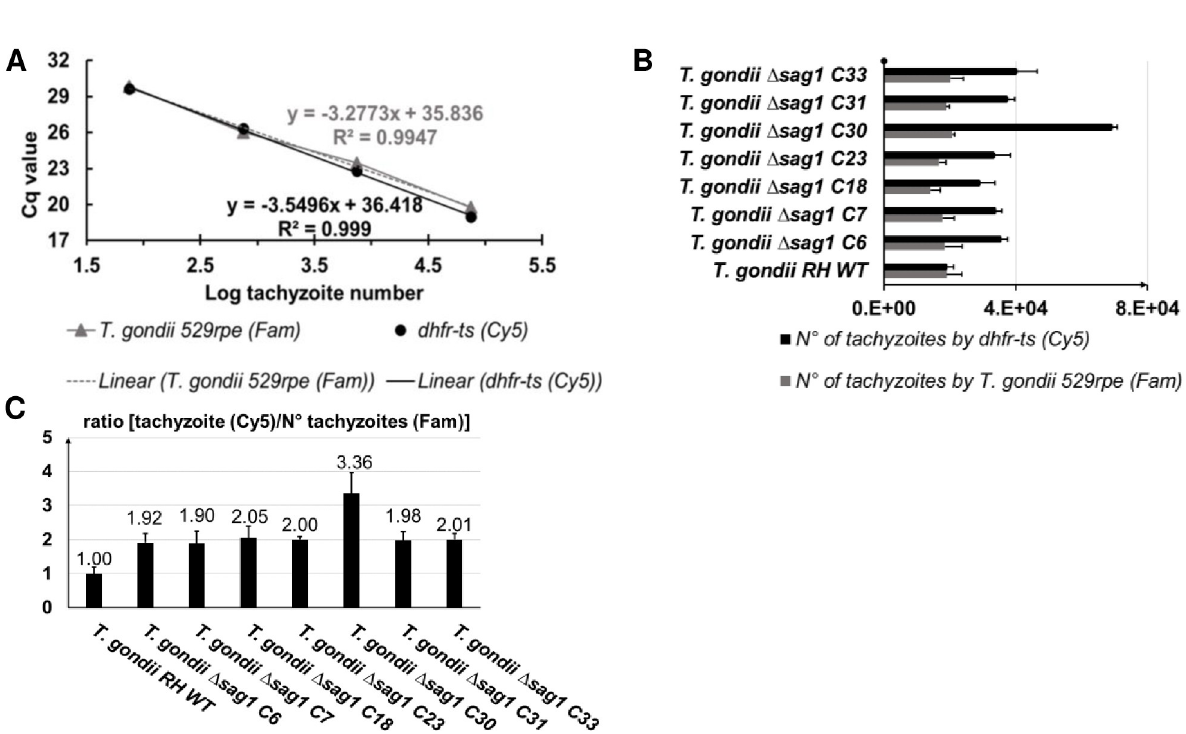
Fig 6. Duplex TaqMan-qPCR for determining copy numbers of integrated mdhfr-ts selectable marker. ( A ) Standard curve was made by using a 10-fold serial dilution of T . gondii RH DNA, with tachyzoites numbers ranging from 75 to 7.5 x 10 5 parasites. ( B ) For each WT or KO clone, the numbers of tachyzoites in the 3 ng DNA was determined according to amplification of dhfr-ts (black bars) and to the T . gondii 529 bp repeat element (grey bars). In ( C ), the number of inserted mdhfr-ts is given by the ratio of the number of tachyzoites as determined by dhfr-ts amplification and the number of tachyzoites determined by using the T . gondii 529 bp repeat element. A ratio equal to 2 indicates a single integration event of the mdhfr-ts in sag1 . Error bars indicate standard deviations of triplicates for each sample.